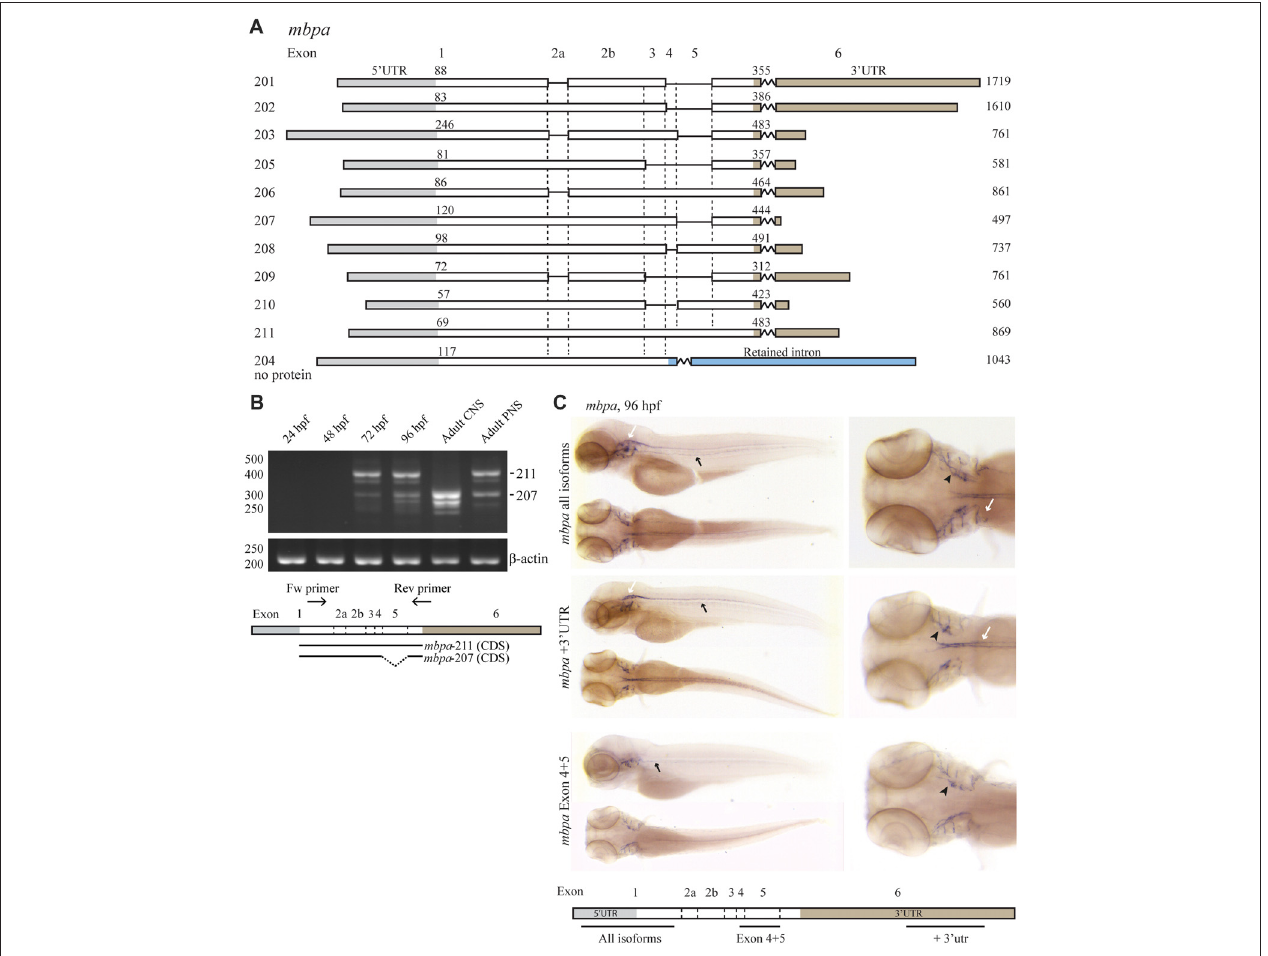
FIGURE 1 | The expression of mbpa isoforms is developmental- and tissue-specific. (A) Schematic illustration of the mbpa isoforms reported in the Ensembl database (release 90). The numbers to the left indicate the identity of the isoform, the numbers above each isoform indicate the position of the first nucleotide in the coding sequence and the 3’UTR, respectively, and the numbers to the right indicate the total reported length. Note that the reported sequences are not complete at the 3’ends. (B) RNA was purified from zebrafish larvae at the indicated hours post fertilization (hpf), and from adult brain (central nervous system, CNS) or lateral line peripheral nervous system (PNS). RT-PCR was performed with equal amounts of RNA as template with a primer set annealing to exon-1 and -6. Primers amplifying β -actin was included as control. The most prominent DNA bands from the CNS and PNS were sequenced and identified as variants 207 and 211 , respectively. (C) Whole-mount in situ hybridization (WISH) was performed on zebrafish larvae at 96 hpf with probes annealing to different positions of the mbpa mRNA, as indicated. The probes annealing to exon-1 ( mbpa all isoforms) and exon-6 ( mbpa +3’UTR) gave similar results, with a distinct signal in the hindbrain and spinal cord of the CNS (white arrows), and in the posterior (black arrows) and anterior (black arrowheads) lateral line system. The probe annealing to exon-4–5 ( mbpa Exon 4 + 5) resulted in a signal in the posterior (black arrows) and anterior (black arrowheads) lateral line system, however, the signal observed in the CNS with the other two probes was completely absent. Images are representative of several larvae from two independent